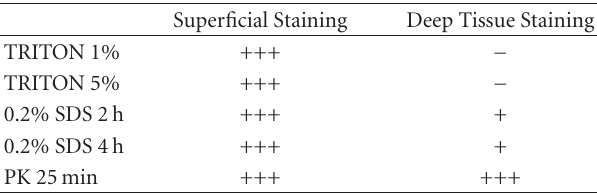
Table 1: Comparative chart of di ff erent permeabilization ap- proaches used in whole mount immunostaining using a biotinyla- ted anti-phosphotyrosine antibody (4G10 clone) and detected with Streptavidin conjugated QDs. Proteinase K treatment is the only ap- proach which allowed deep tissue staining using